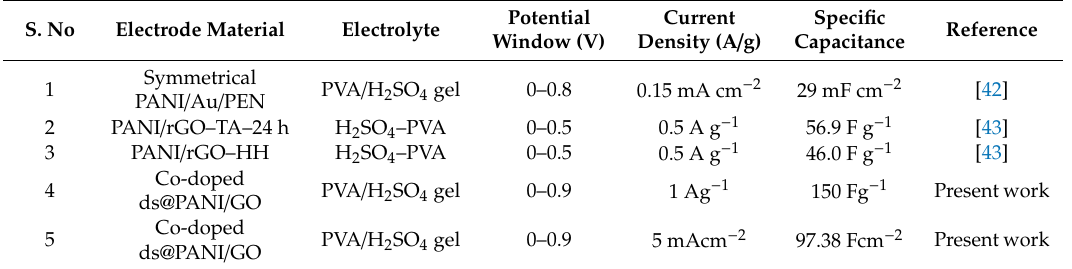
Table 2. Comparison of the performances of the fabricated device with similar previous works.